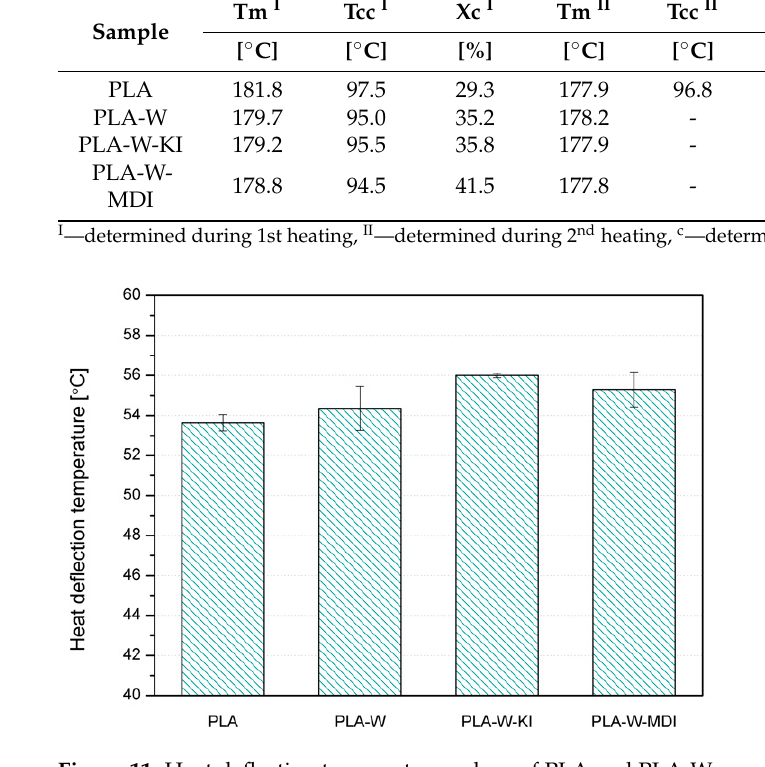
Figure 11. Heat deflection temperature values of PLA and PLA-W composites.